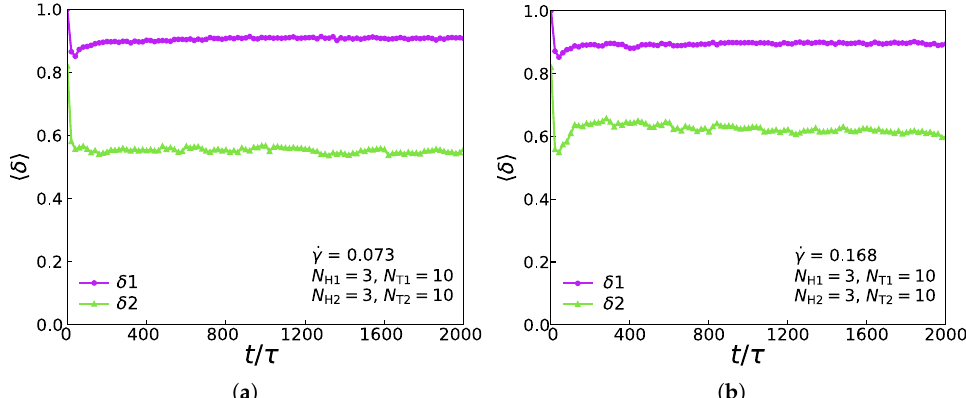
Figure 8. The shape factor of the asymmetric membrane for the first type of lipid chain ( δ 1) and the second type of lipid chain ( δ 2) with ( a ) ˙ γ = 0.073 and ( b ) ˙ γ =